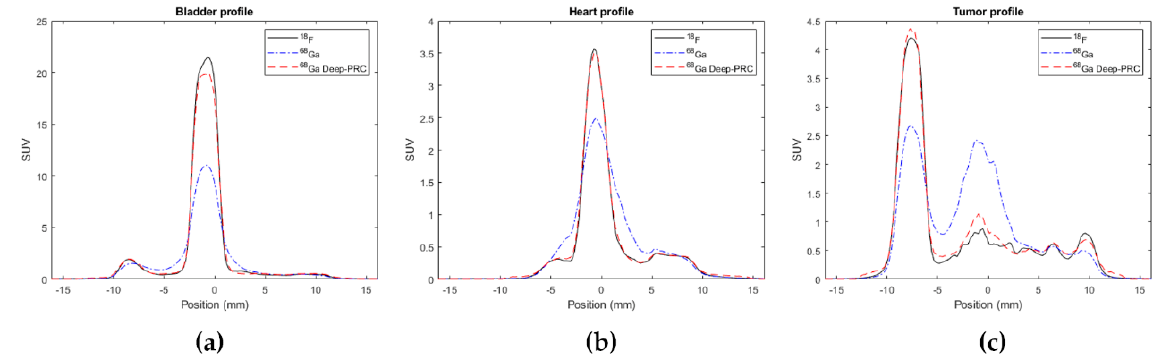
Figure 7. Profiles across different regions in the 18 F, 68 Ga, and 68 Ga with Deep-PRC images: bladder ( a ), heart ( b ), and tumor ( c ).